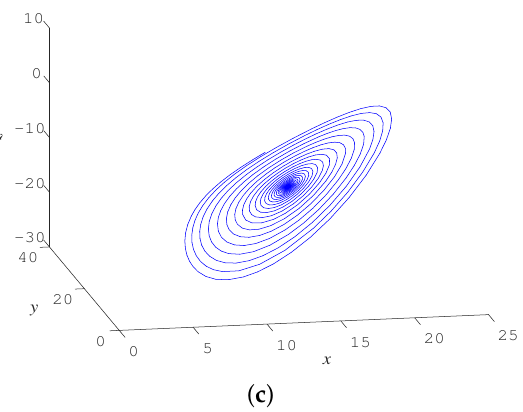
Figure 6. 3D view of phase portraits of system (1), where a = 10, c = 11.2, k = − 0.2: ( a ) b = 20, ( b ) b = 80, ( c ) b = 130.